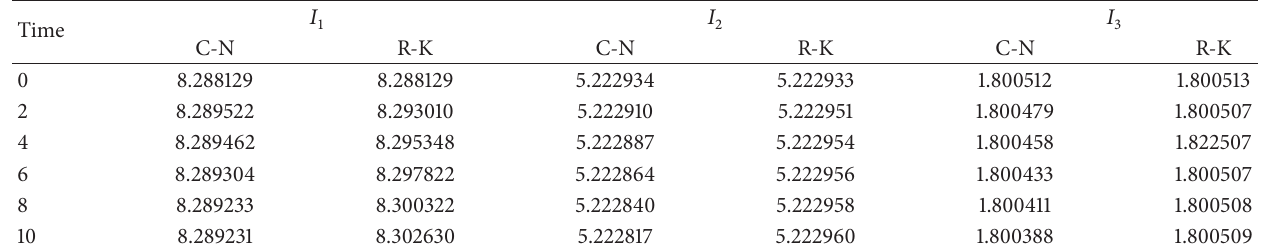
Table 10: Invariants and error norms for two solitary waves, 𝑐 1 = 1 , 𝑐 2 = 0.5 , 𝑥 1 = 10 , 𝑥 2 = 40 , ℎ = 0.1 , 𝑘 = 0.01 , and 0 ≤ 𝑥 ≤ 100 .